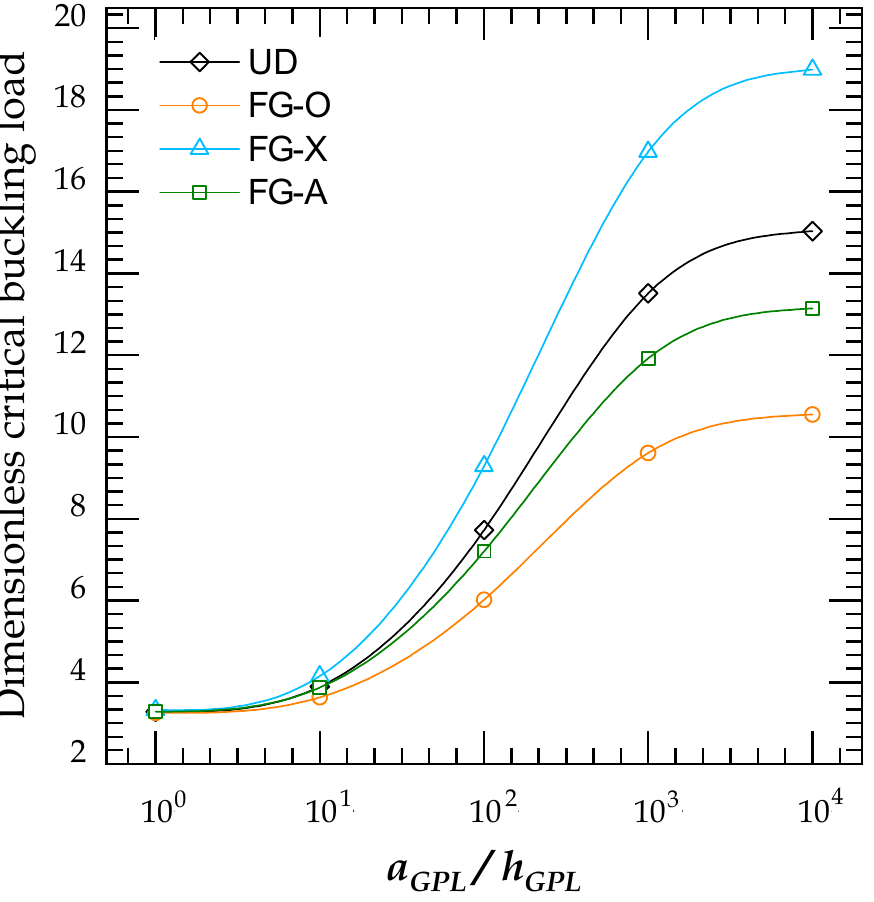
Figure 5. Dimensionless critical buckling load of simply supported GRNC plate versus the length-to- thickness ratio of the GPLs nanofillers (g